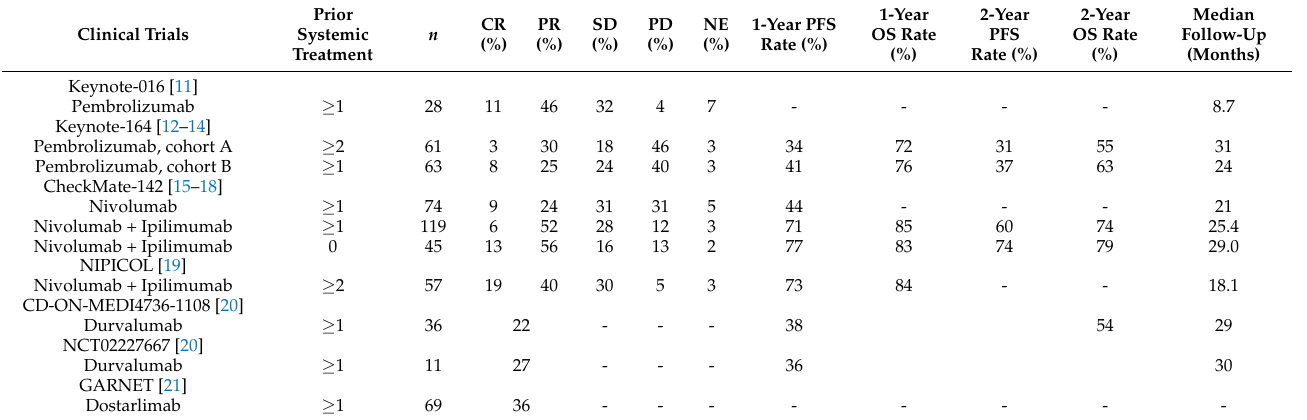
Table 1. Immune checkpoint inhibitors in MSI/dMMR metastatic colorectal